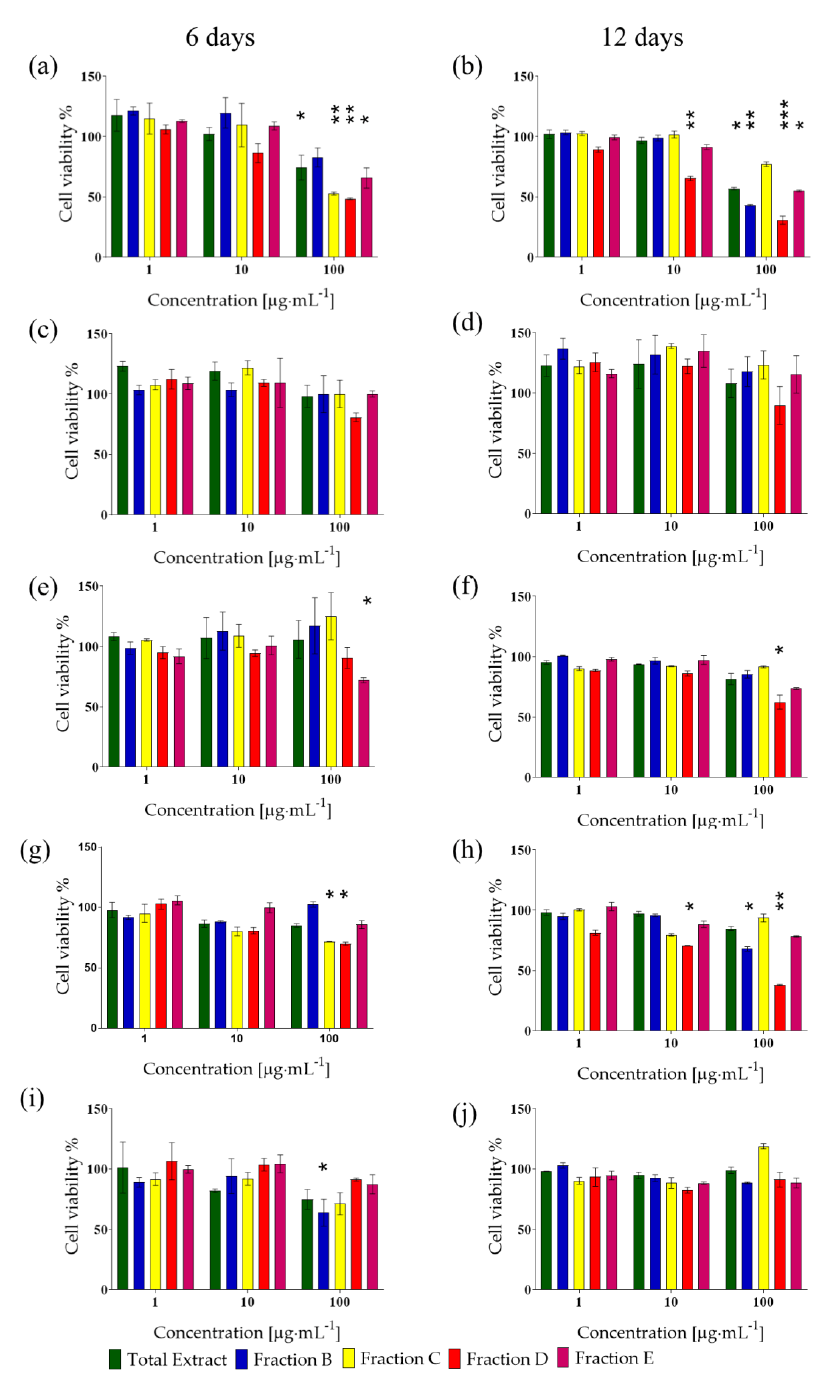
Figure 1. Cell viability assay. Antiproliferative effects of TE (green bars) or fractions (B blue bars; C yellow bars; D red bars; E purple bars) of Isochrysis galbana cultured for 6 days or 12 days on A2058 ( a , b ), HaCat ( c , d ), A549 ( e , f ), MRC5 ( g , h ) and HepG2 ( i , j ). Cell viability was normalized using cells incubated with complete cell medium in the presence of DMSO as a control sample. Results are expressed as percent survival after 72 h exposure (n = 3; * for p < 0,05; ** for p < 0.01 and *** for p < 0.001, Student’s t -test).